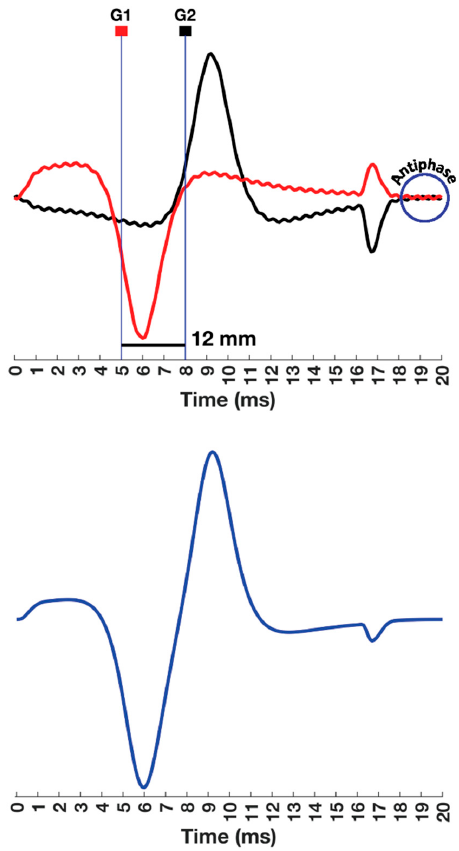
Figure 8. An illustration of common mode rejection associated with the bipolar electrode configuration. Continuing with the approach depicted in Figure 7, two monopolar compound muscle action potentials (CMAPs) are presented in the top panel. The CMAPs recorded by G1 (red) and G2 (black) are contaminated by a common mode signal. The signal recorded by G2 is inverted, so it is antiphase to that present in G1 and is cancelled (bottom panel). Since the time scale of the MUAP is 20 ms, a small amplitude 2 kHz sinusoid was created to illustrate a common mode signal that could also be observed in the baselines of G1 and G2 after the muscle fiber–tendon end effects. Wire loops such as electrode leads are suspectable to electromagnetic field-induced current, which is often overlooked. The larger the loop area, the larger the current induced by the power line magnetic field. For this reason, wires are twisted to reduce the area [83,84]. Twisting the leads of G1 and G2 in a close bipolar configuration is much easier to